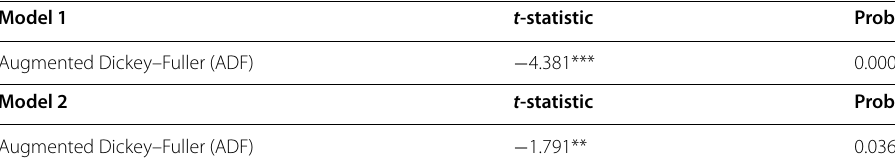
Table 3 Kao panel cointegration test results